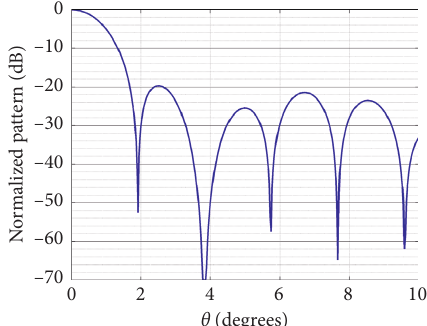
Figure 8: The two-way array pattern for N elements. SLL � − 47.4dB.